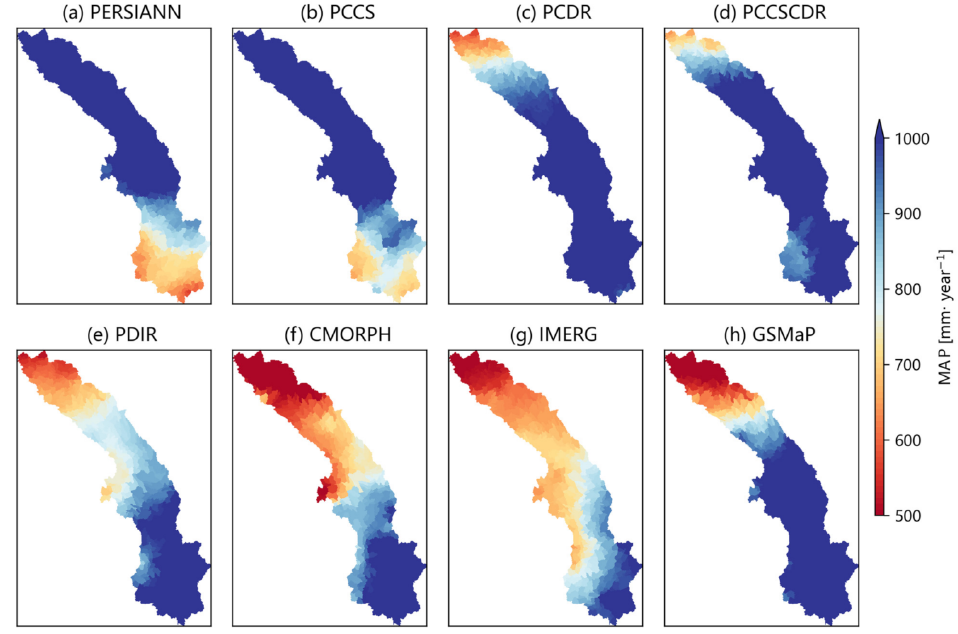
Figure 2. The spatial distribution of mean annual precipitation (MAP) (2003–2019) for eight SPEs ( a – h ) in the YLJ